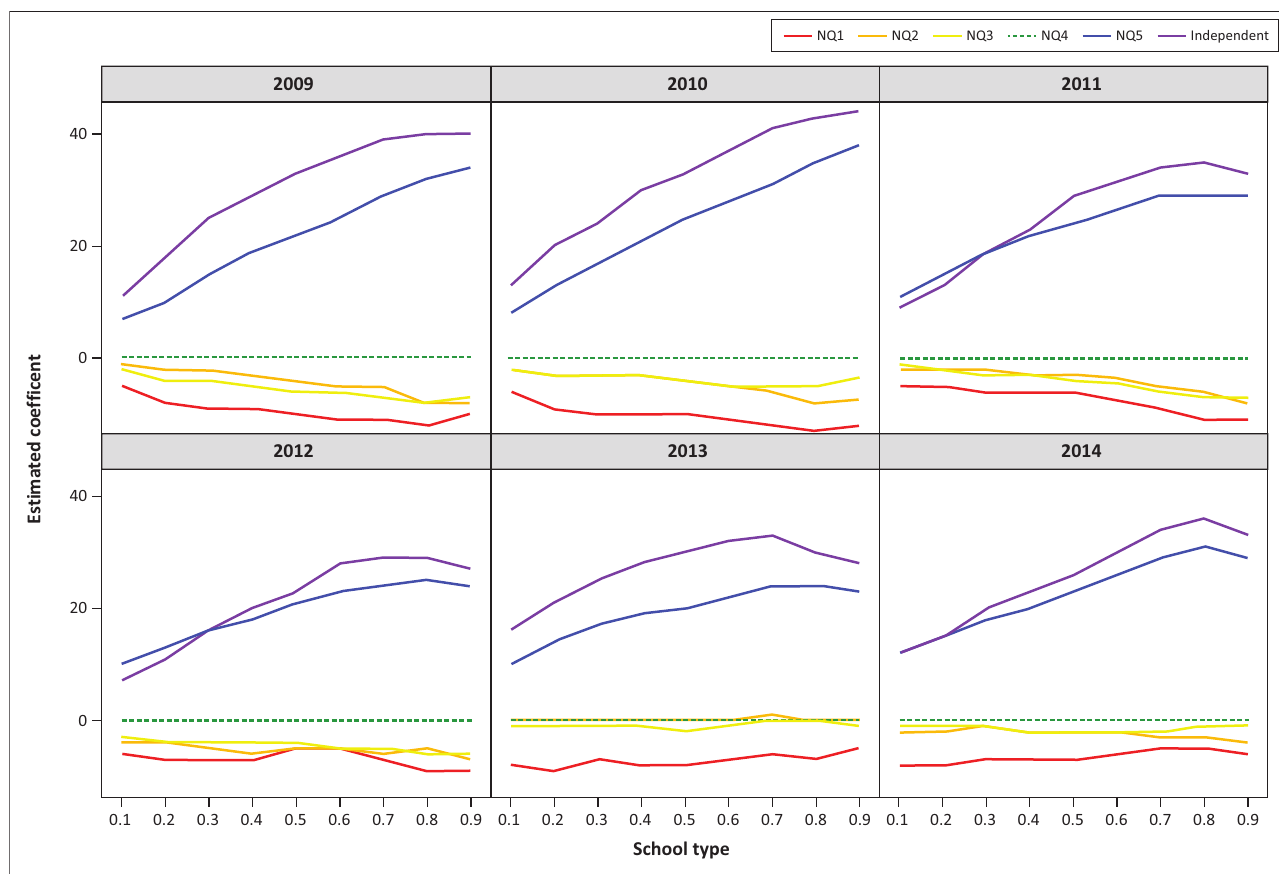
FIGURE 4: Parameter estimate differences between the specified school quintile type and NQ4 schools across the different